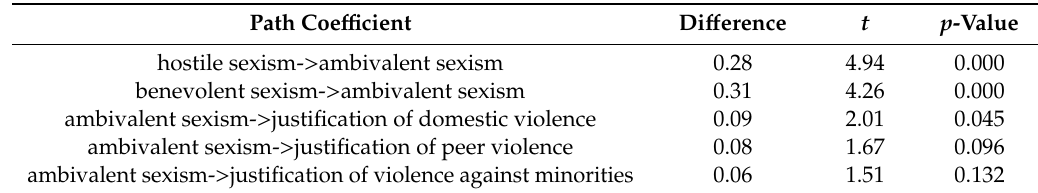
Table 4. Girls against boys: differences in path coefficients.